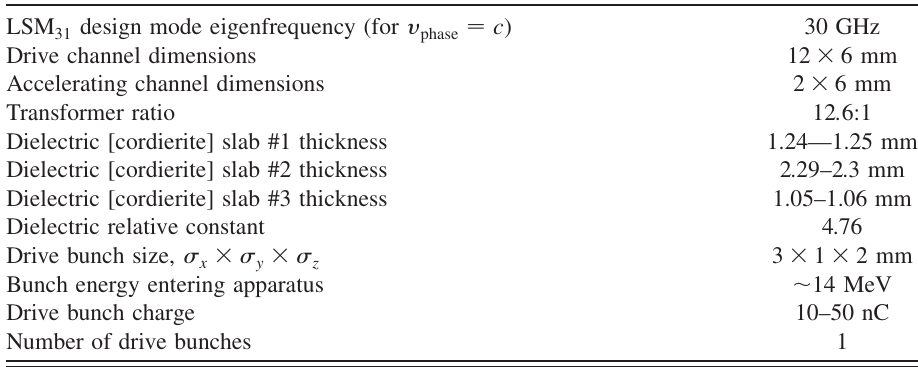
TABLE I. Parameters of the two-channel dielectric-lined wakefield accelerator